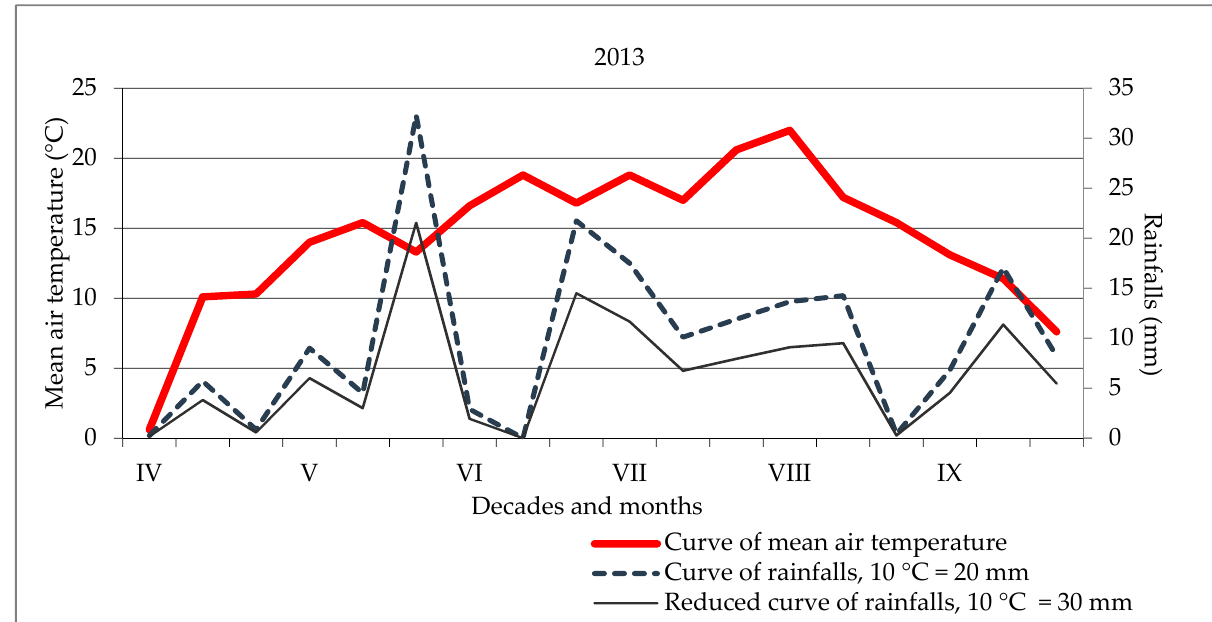
Figure 2. Climatic diagram for meteorological conditions from April to September (IV–IX) in 2012.